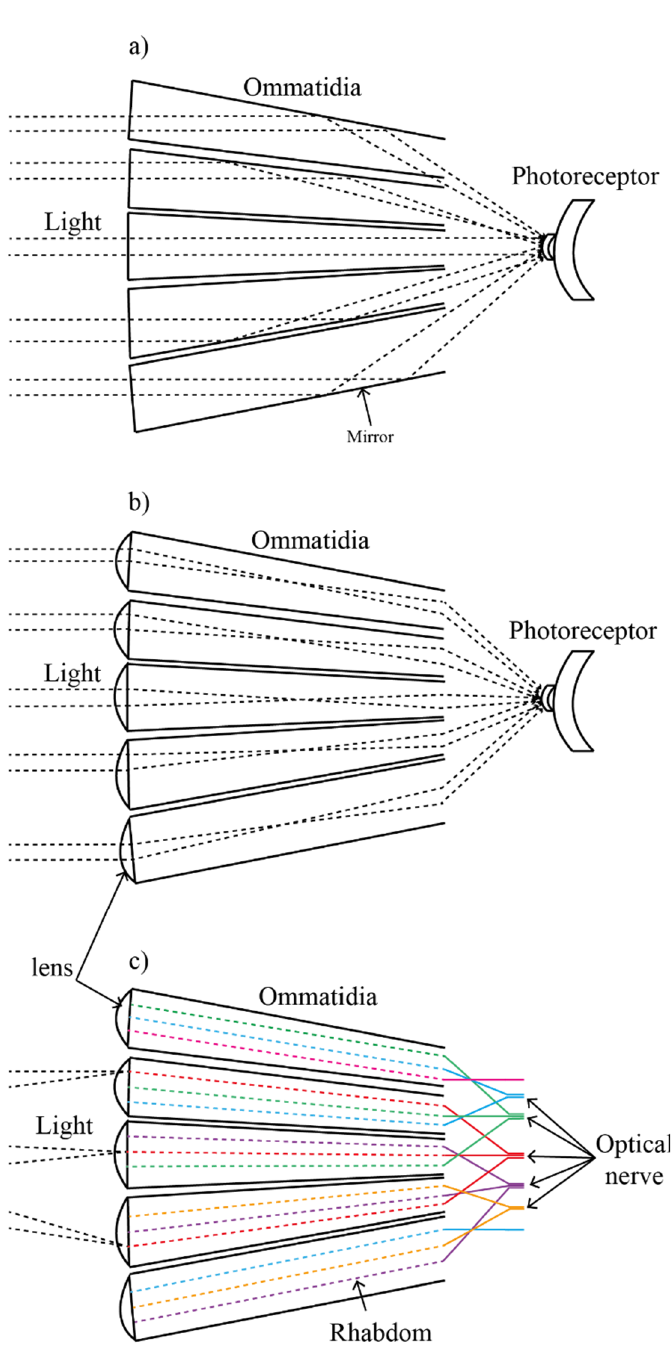
Figure 2. Types of the superposition compound eye: ( a ) The reflective supposition compound eyes, ( b ) the refractive superposition compound eyes, and ( c ) the neural superposition compound eyes.